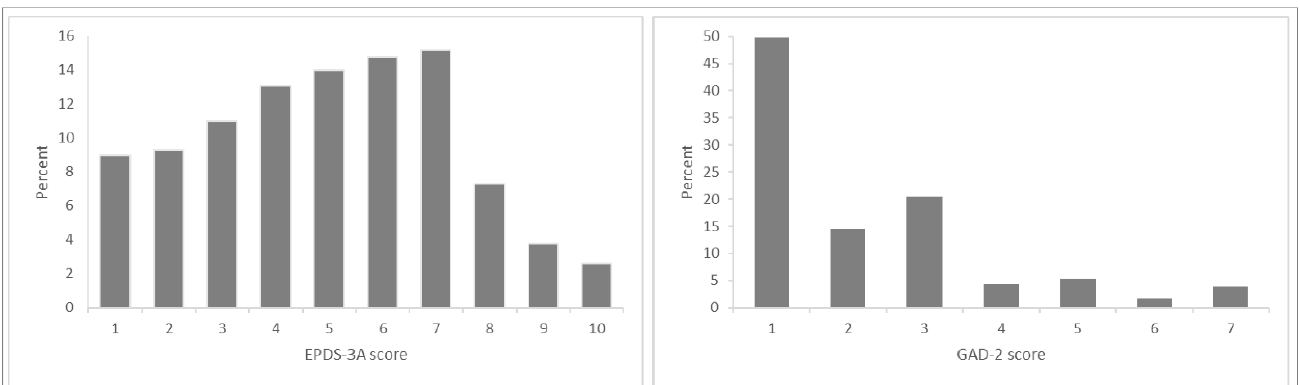
Figure 1. Distribution of total GAD-2 and EPDS-3A scores.